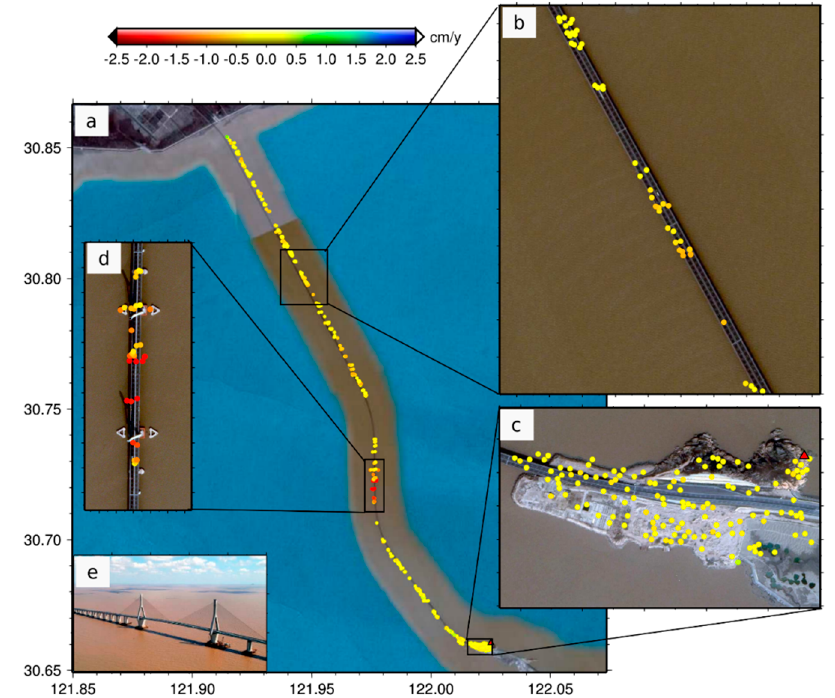
Figure 7. ( a ) The deformation rates of the identified TCPs for the Donghai Bridge; ( b ) An enlarged view of the deformation rates of the pier-stayed part of the bridge; ( c ) An enlarged view of the deformation rates of the island. Triangles represent the reference point; ( d ) An enlarged view of the deformation rates of the cable-stayed part of the bridge; ( e ) A field picture of the cable-stayed part of the bridge. The figure is plotted in the WGS 84 coordinate system.